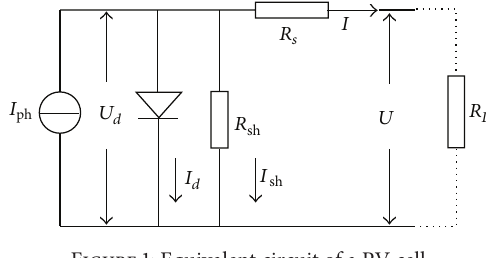
Figure 1: Equivalent circuit of a PV